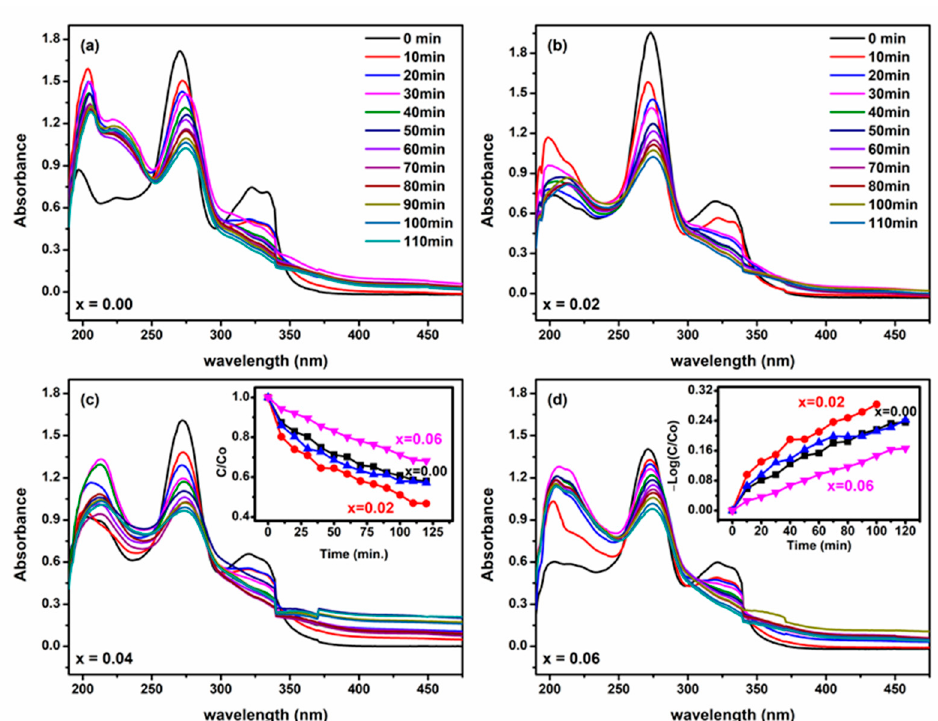
Figure 7. Photocatalytic degradation of CIP by using [BiFe 1 − x Li x O 3 ]-graphene nanocomposites. ( a ) x = 0.00, ( b ) x = 0.02, ( c ) x = 0.04 and ( d ) x = 0.06. Inset ( c ) and ( d ) shows the C/C o vs. time and − Log(C/C o ) vs. time of CIP degradation with [BiFe 1 − x Li x O 3 ]-graphene nanocomposites.